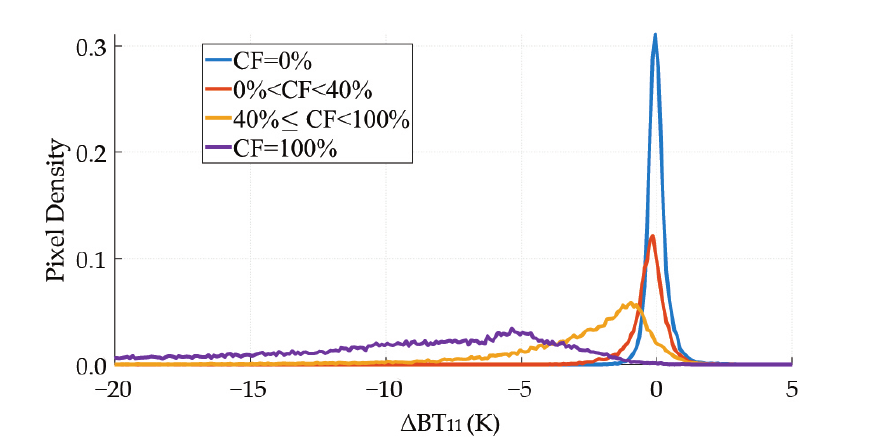
Figure 7. ∆ BT 11 probability density functions of different cloud fraction